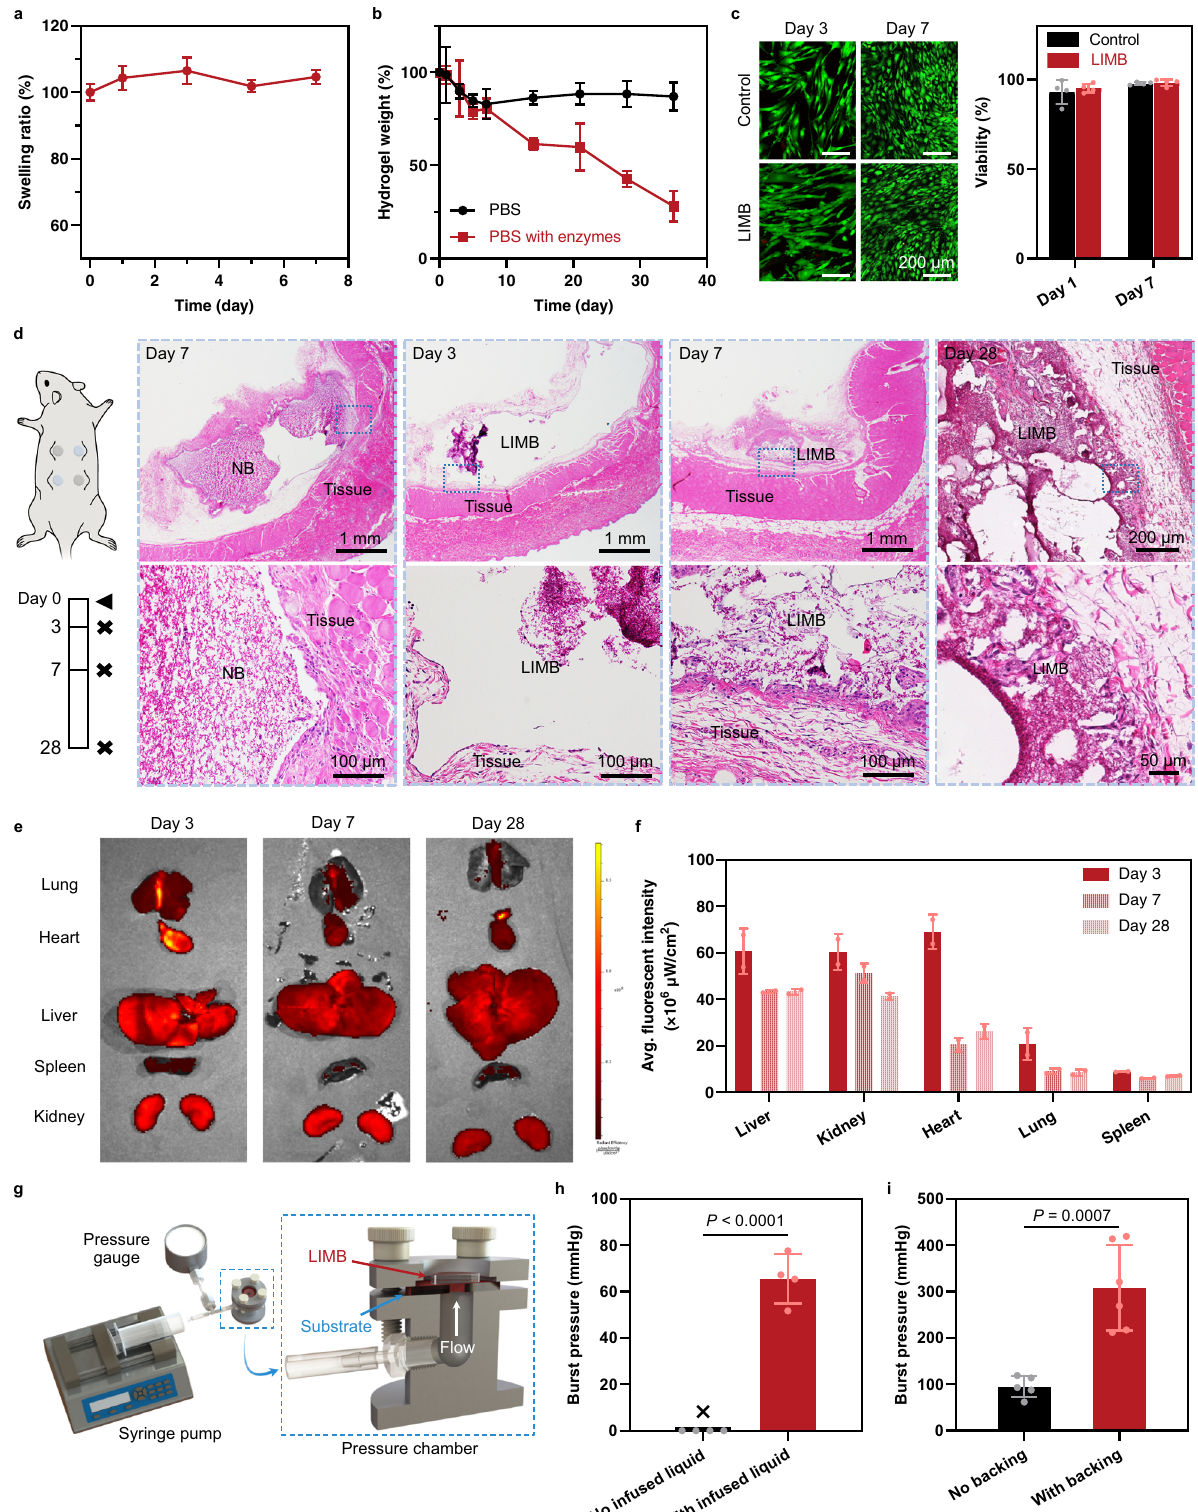
(Fig. 5a and Supplementary Fig. 17). The liver defect receives LIMB or SURGIFOAM of the same size. The hemostatic ef fi cacy of LIMB is manifested with low blood loss (99.8 mg) and quick time to hemostasis (31.5 s). Compared with 517.1 mg and 165.8 s for SUR- GIFOAM, our material achieves an overall 5-fold improvement in both criteria (Fig. 5b,